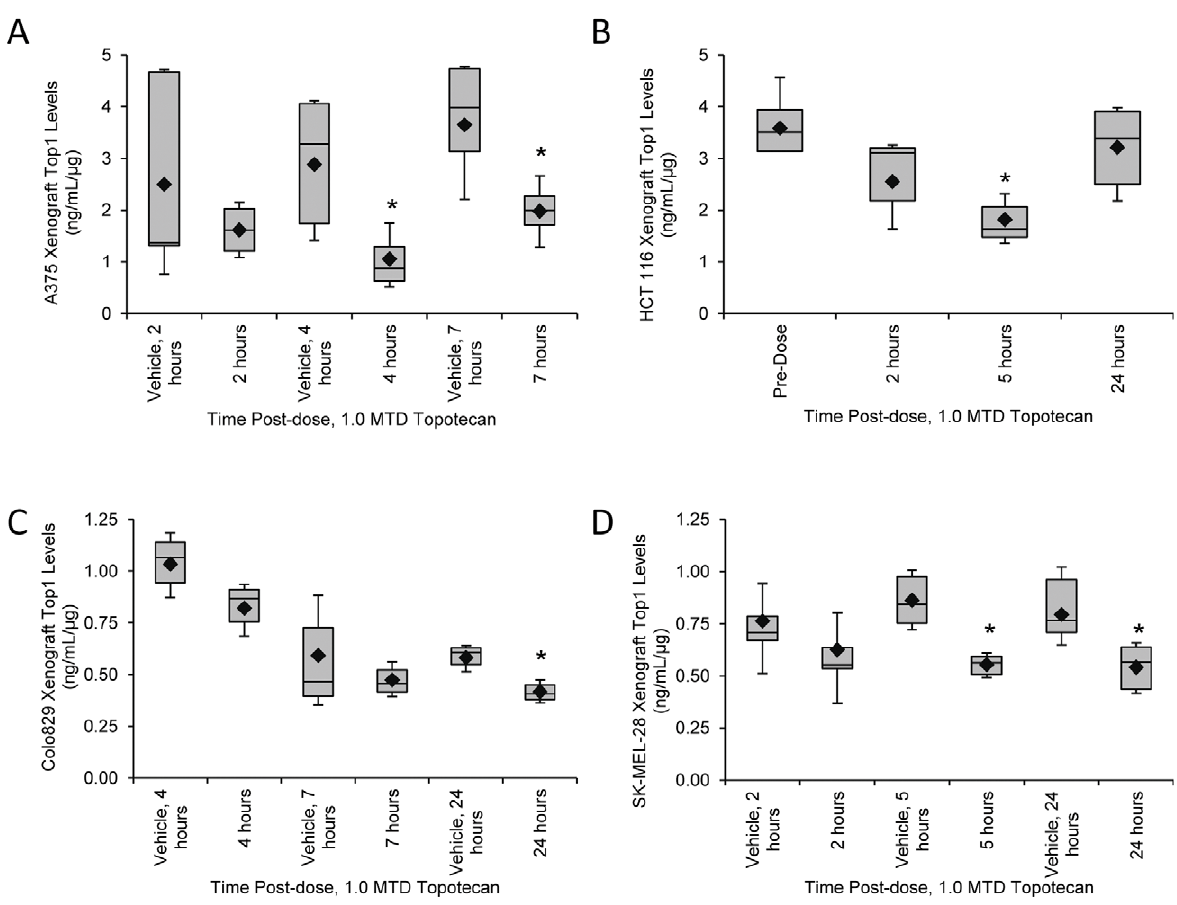
Figure 2. Top1 levels in topotecan-responsive and -nonresponsive xenograft models. Mice treated with water vehicle or single dose 1.0 MTD topotecan for the designated times were assessed for Top1 levels using the validated immunoassay. (A) Mice bearing A375, topotecan- responsive xenografts were collected 2, 4, or 7 hours after treatment (n=4/cohort). (B) HCT 116 colon cancer xenografts were collected 2, 5, and 24 hours after treatment and compared to baseline (0 h, no vehicle). n=3–6 topotecan-treated mice/cohort and n=12 in the 0 h cohort. (C) Colo829 xenografts were collected 4, 7, or 24 hours after treatment (n=3/cohort). (D) SK-MEL-28 xenografts were collected 2, 5, or 24 hours after treatment (n=6/cohort). Box plots represent interquartile range, 10 th and 90 th percentile whiskers, and median Top1 levels; diamonds represent group mean. Asterisks (*), treatment cohort mean was statistically different from the vehicle mean at same time point (or baseline in the HCT 116 cohorts), with a significance level of P # 0.05, as determined by Student’s one-tailed t